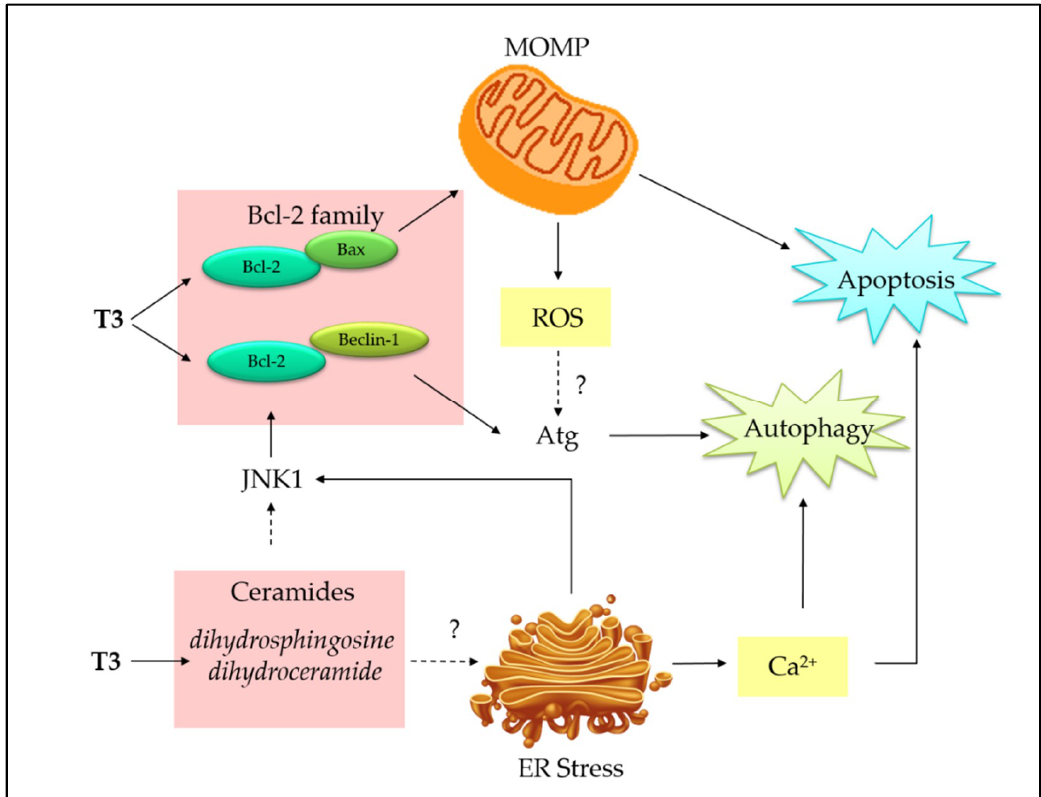
Figure 5. Schematic representation of potential interactions between tocotrienols-induced apoptosis and autophagy. Tocotrienols bind to Bcl-2 protein to displace proapoptotic protein (i.e., Bax) and proautophagic protein (Beclin-1) to initiate apoptosis and autophagy, respectively. Bax initiates MOMP to induce apoptosis, leading to generation of ROS, which serves as a second messenger to trigger the expression of autophagy-related protein (Atg). Tocotrienols upregulate de novo synthesis of ceramides, which can activate JNK signaling by phosphorylating Bcl-2 family proteins and induce Ca 2+ release by ER stress, eventually resulting in apoptosis and autophagy. “?” indicates more investigations are required.